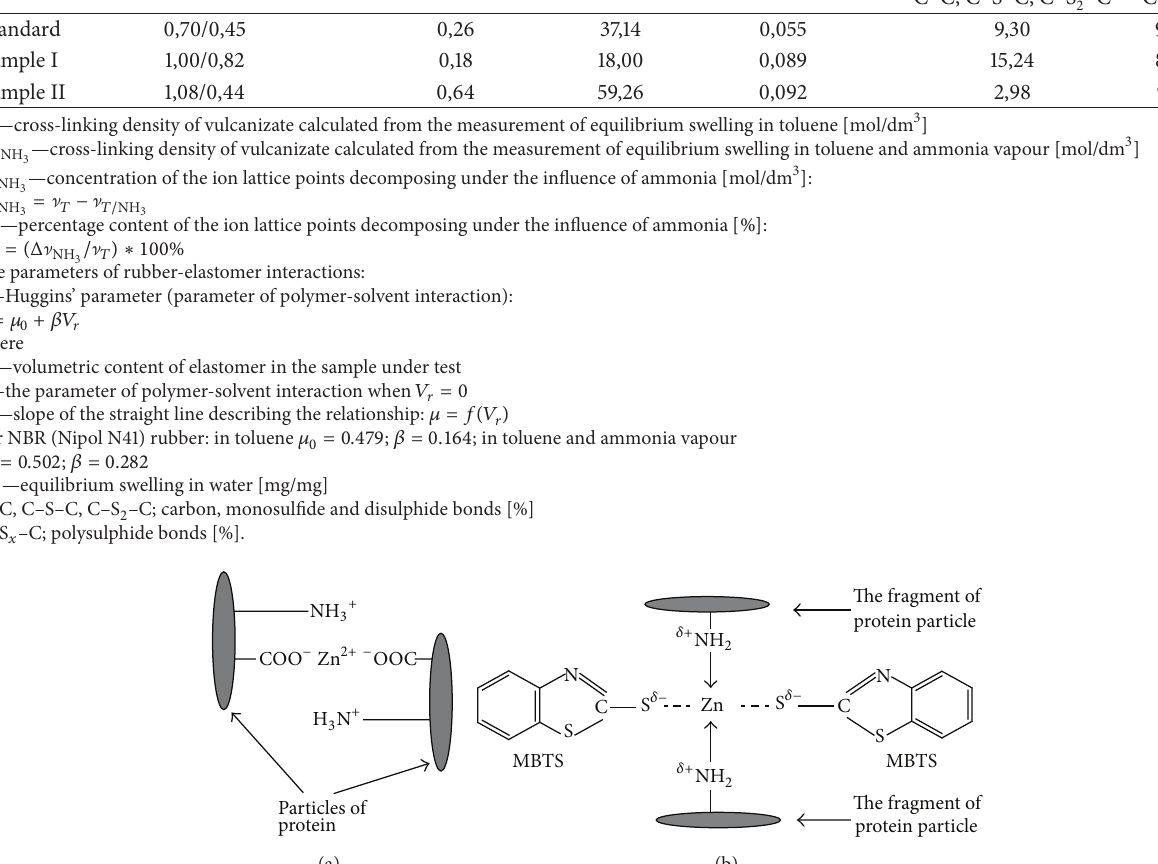
Table 2: Cross-linking density determined by measurement of equilibrium module and equilibrium swelling. Symbol